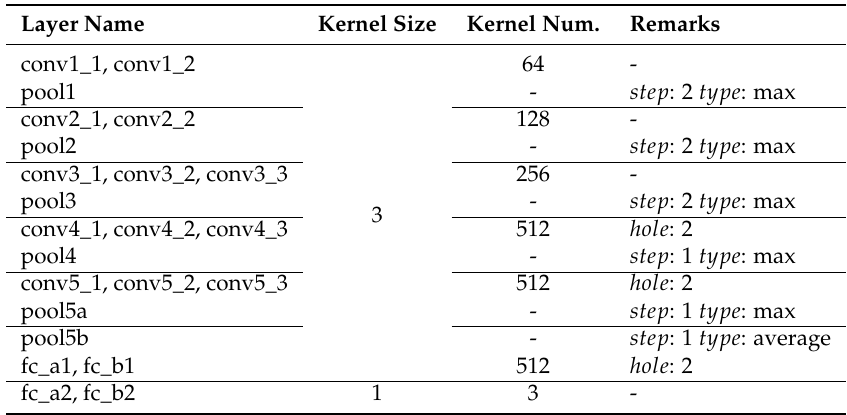
Table 1. The setup of the